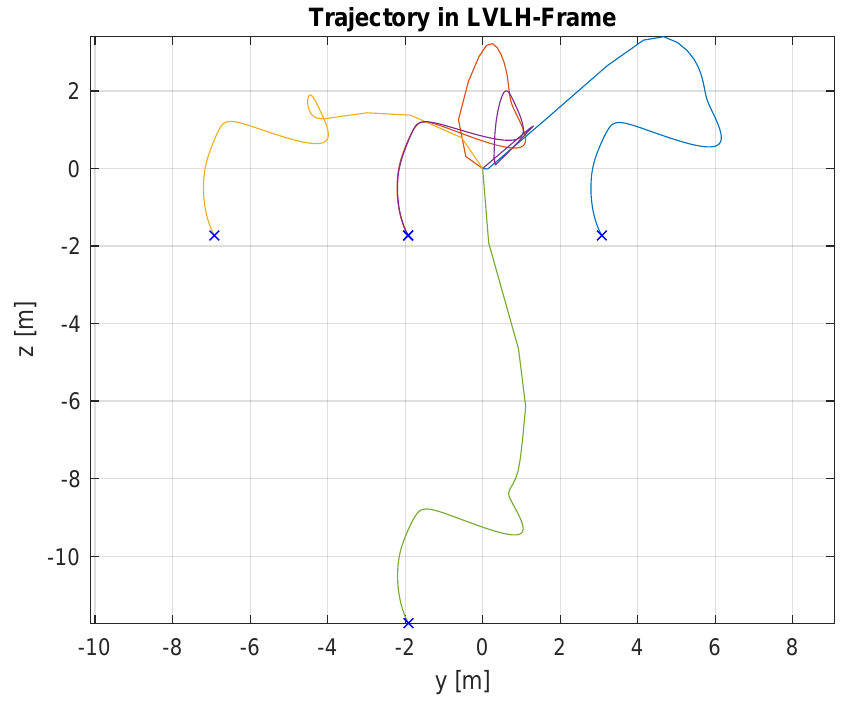
Figure 15. The y–z motion of the trajectories of the five satellites subject to the presented consensus-based controller starting on v-bar ( − 20, − 10,0,10,20